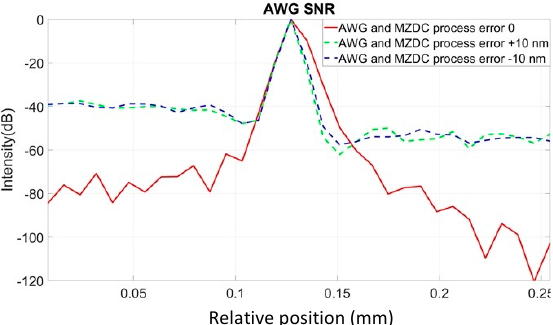
Figure 11. PSF from the MZDC interrogated with AWG.